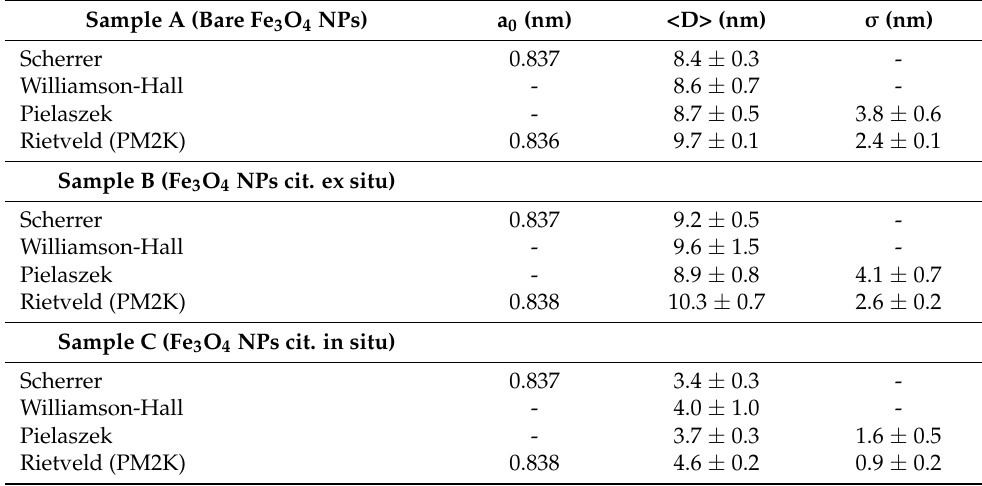
Table 1. Results of the analysis of the diffractograms by using the various methods. The accuracy on the lattice parameter is ± 0.001 nm. <D> calculated with all methods is the average weighted by the volume. For Scherrer and Pielaszek methods, the values of <D> are the average of the values derived from the widths of the most intense peaks in the diffractrograms. σ is the standard deviation of the